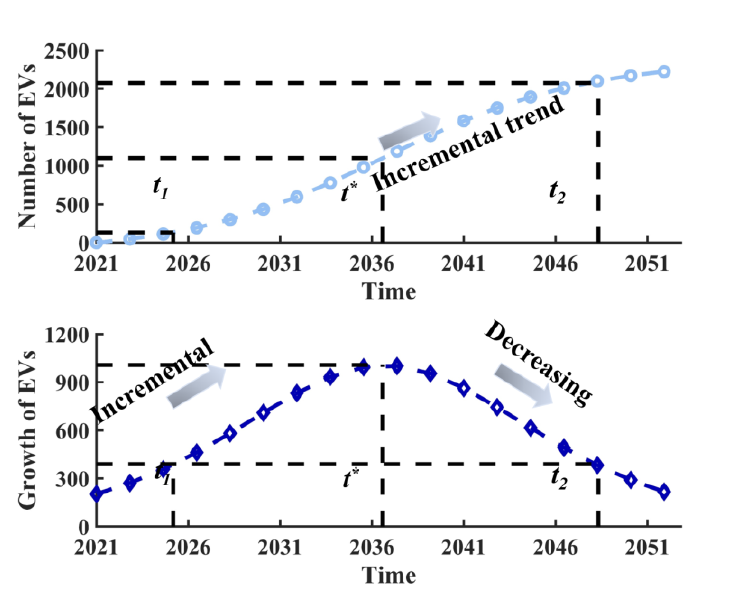
Figure 4. Development process of EV